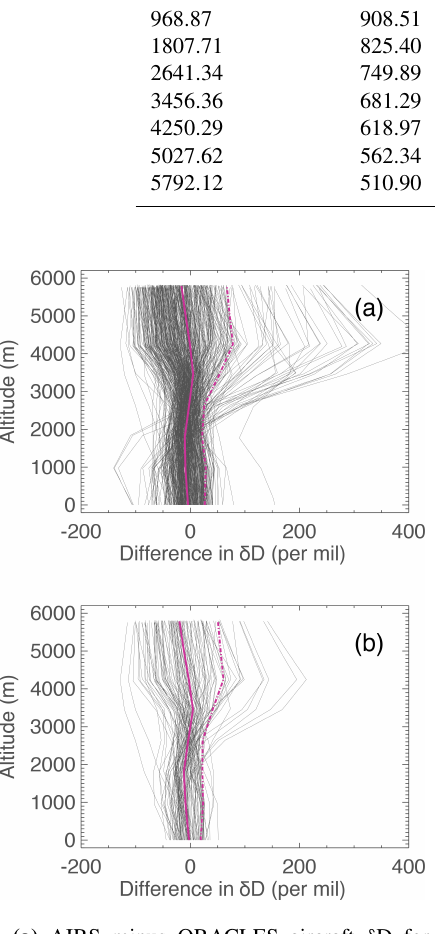
Figure 4. (a) AIRS minus ORACLES aircraft δ D for the 446 matches within the loose spatial matching constraint (Fig. 2, open circles). Lines are individual profiles (black lines), mean (solid red line) and rms (dashed–dotted red line). (b) AIRS minus ORACLES aircraft δ D for the 110 matches within 0.3 ◦ (Fig. 2, closed circles).